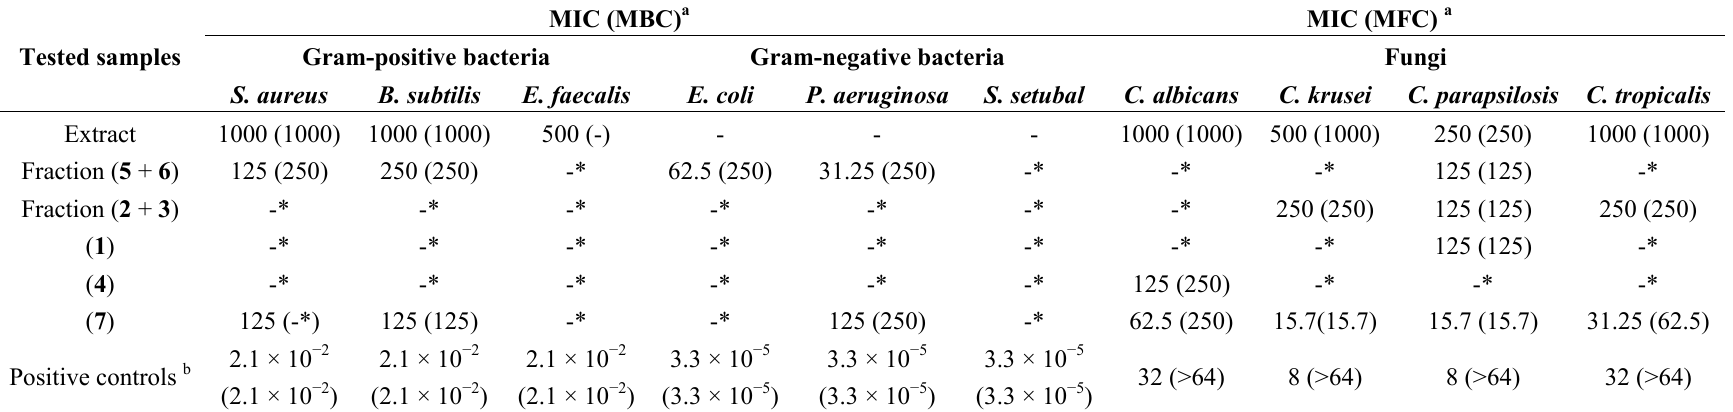
a Values given as µg/mL. b ciprofloxacin for bacteria and fluconazole for fungi (-) MIC/MBC/MFC > 1000 µg/mL; (-*) MIC/MBC/MFC > 500 µg/mL. MIC: minimum inhibitory concentration; MBC/MFC: minimum bactericidal/fungicial